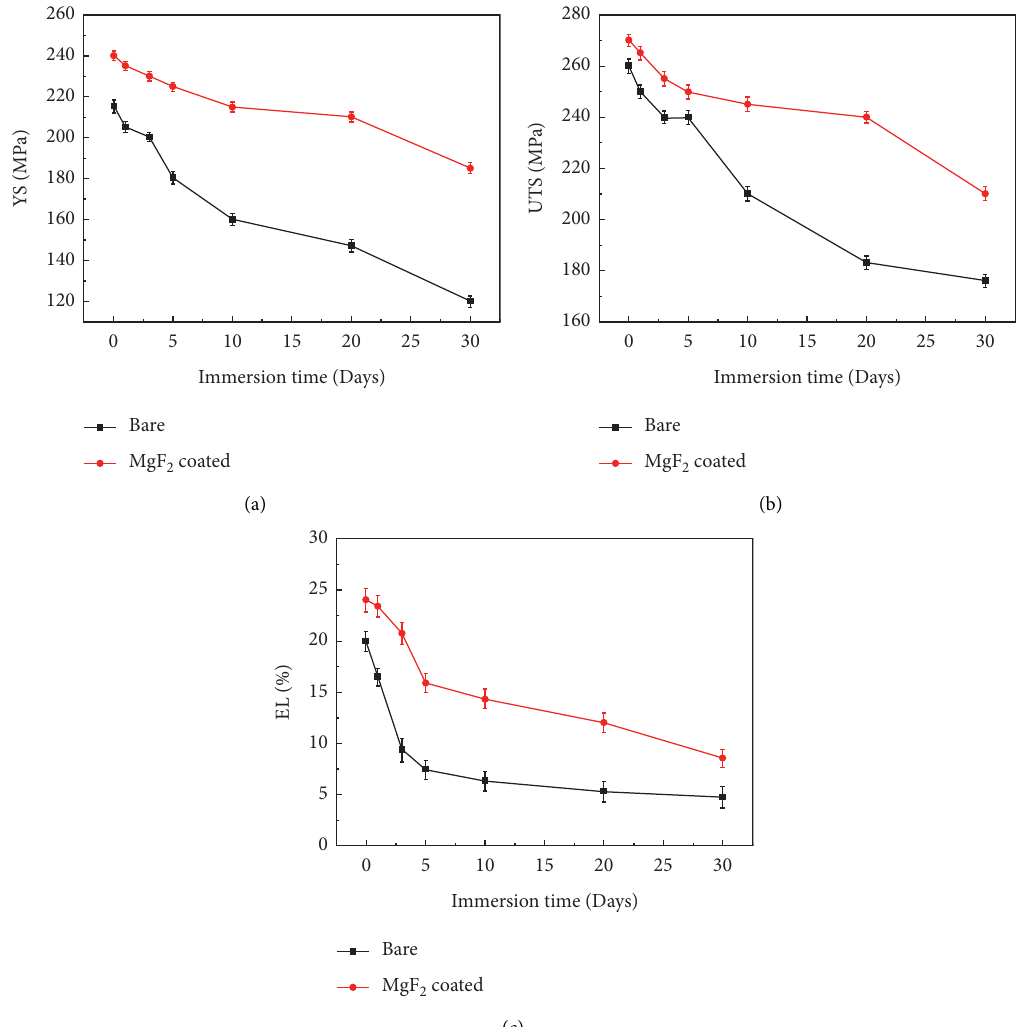
Figure 8: Bare and MgF 2 -coated MZZ during immersion for 30 days. (a) YS, (b) UTS, and (c) EL [68].